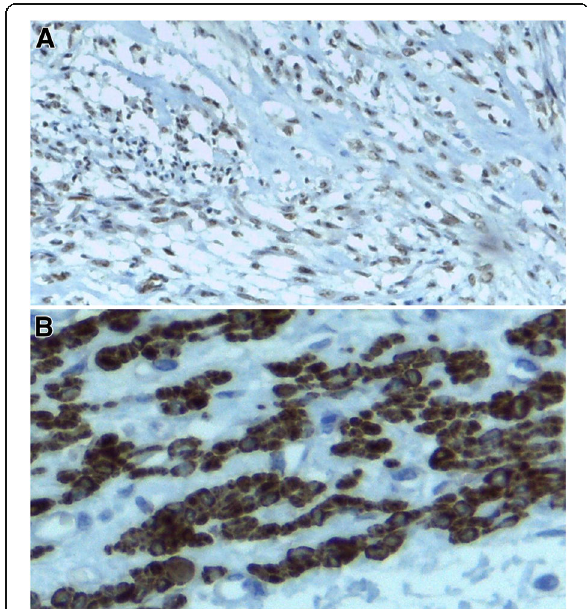
Fig. 3 a Strongly and diffusely intranuclear staining of the tumour cells with SMA (IHC, × 40). b Strongly and diffusely intranuclear staining of the tumour cells with desmin (IHC, ×